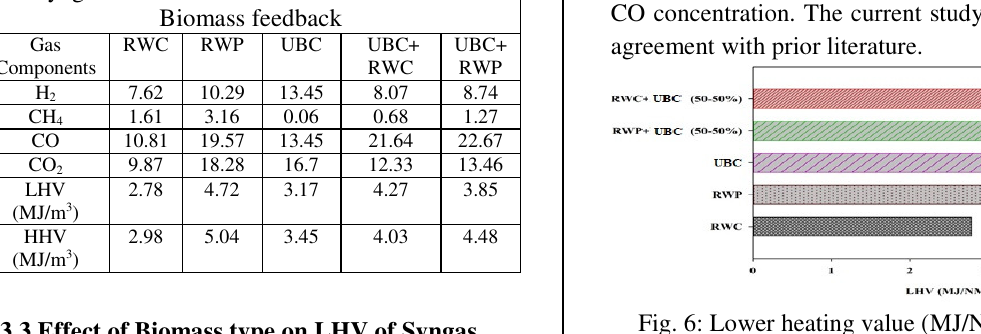
Fig. 6: Lower heating value (MJ/Nm 3 ) of syngas produced from different biomass